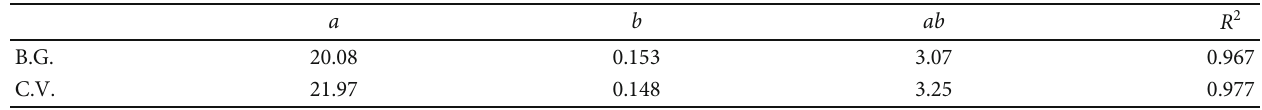
Table 2: Criteria of multiple kinetic models for B.G. and C.V. dyes ’ adsorption on the surface of binary P3NT/30%AgTiO2 NCs at 295K. (a) Fractional power function kinetic